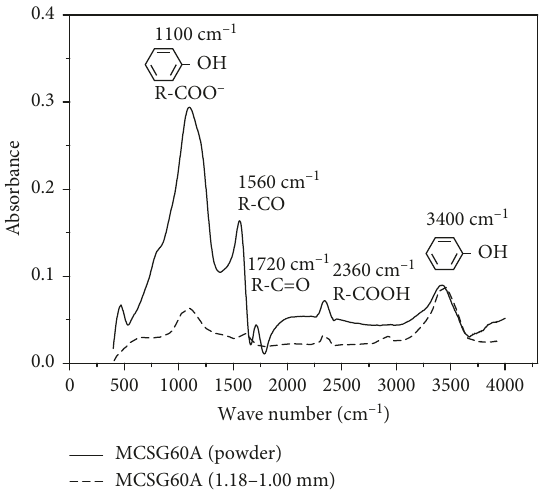
Figure 3: FT-IR analysis for MCSG60A with two different particle sizes.